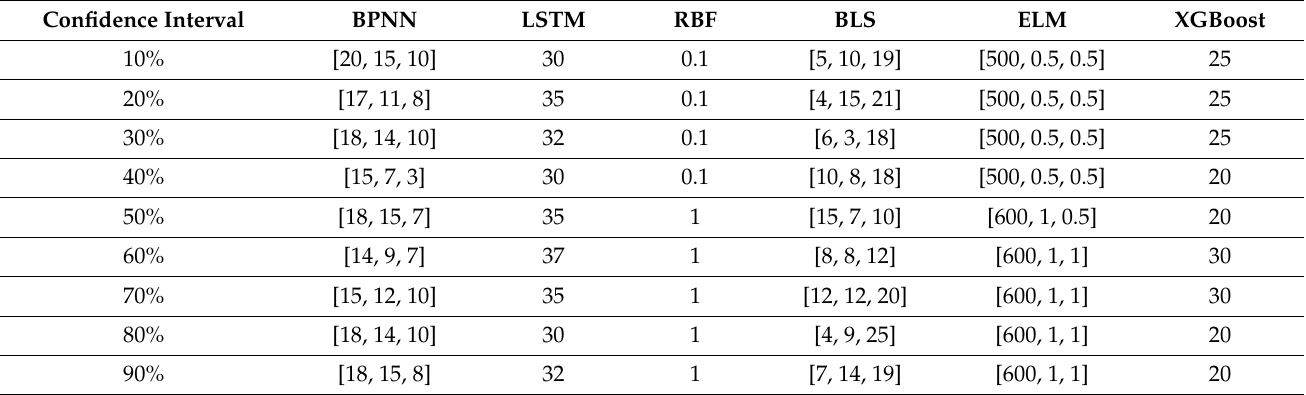
Table 2. Parameter settings of different models with different confidence intervals in Set 1.